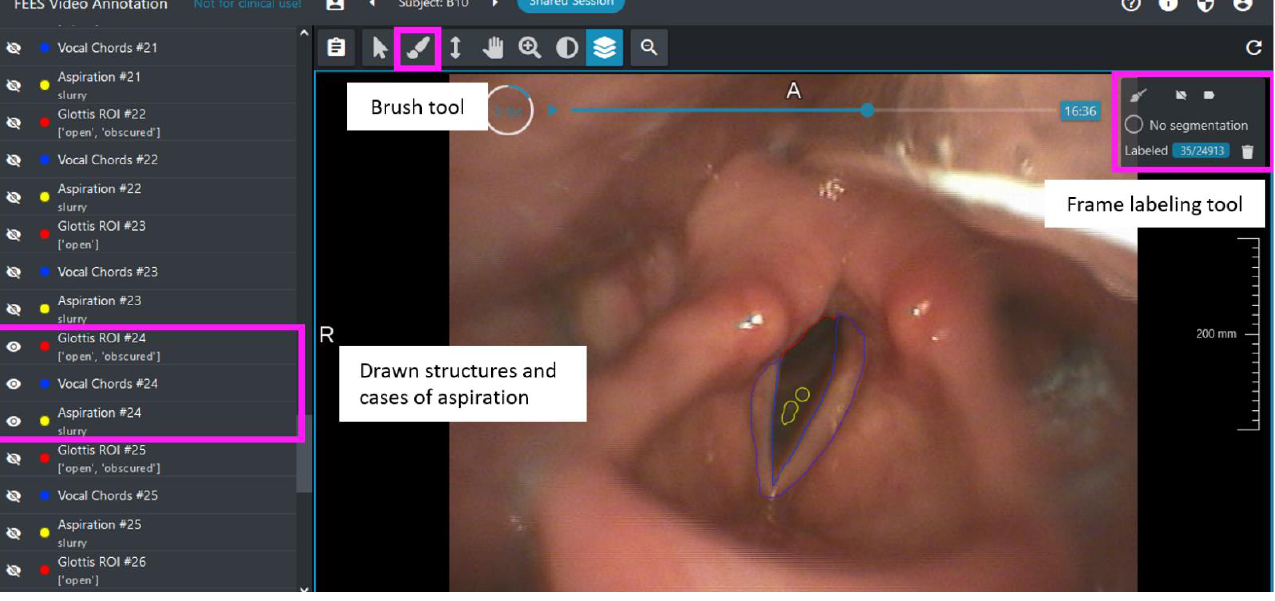
Figure 1. Annotation example with drawn structures of vocal cords (red), glottis (blue) and cases of aspiration (yellow) using the frame-labeling tool (screenshot).